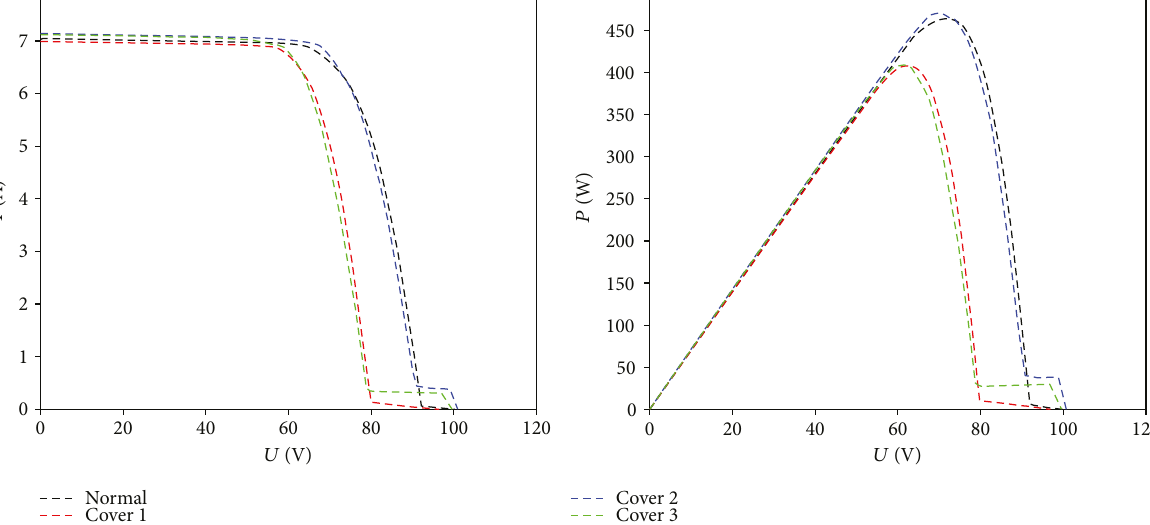
Figure 14: Comparison of the results of the shadow and the cover shading experiments. The di ff erence between shadow and cover is whether the open-circuit voltage drops or